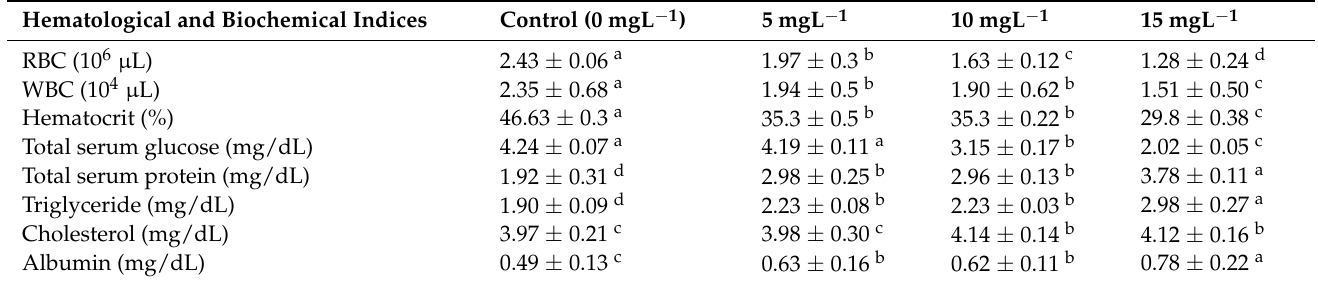
Table 3. Hematological and biochemical endpoints (mean ± SD) of C. capoeta after exposure to different levels of Ag-NPs at 96